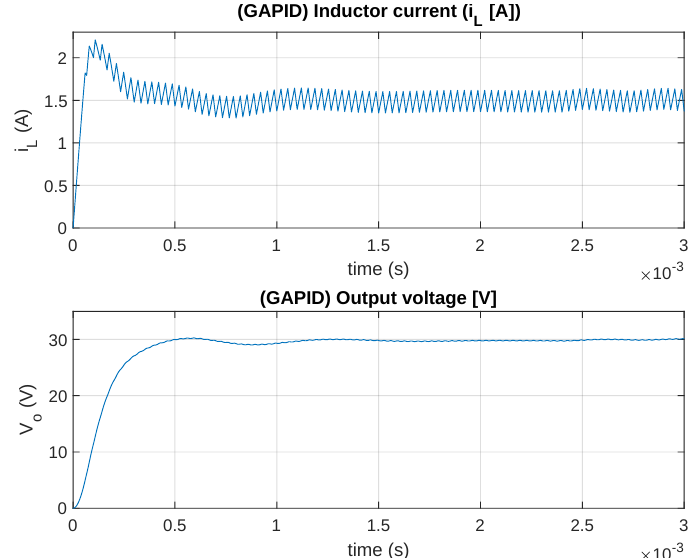
Figure 11. Inductor current i L and output voltage V c under GAPID control with DE2 best parameters.